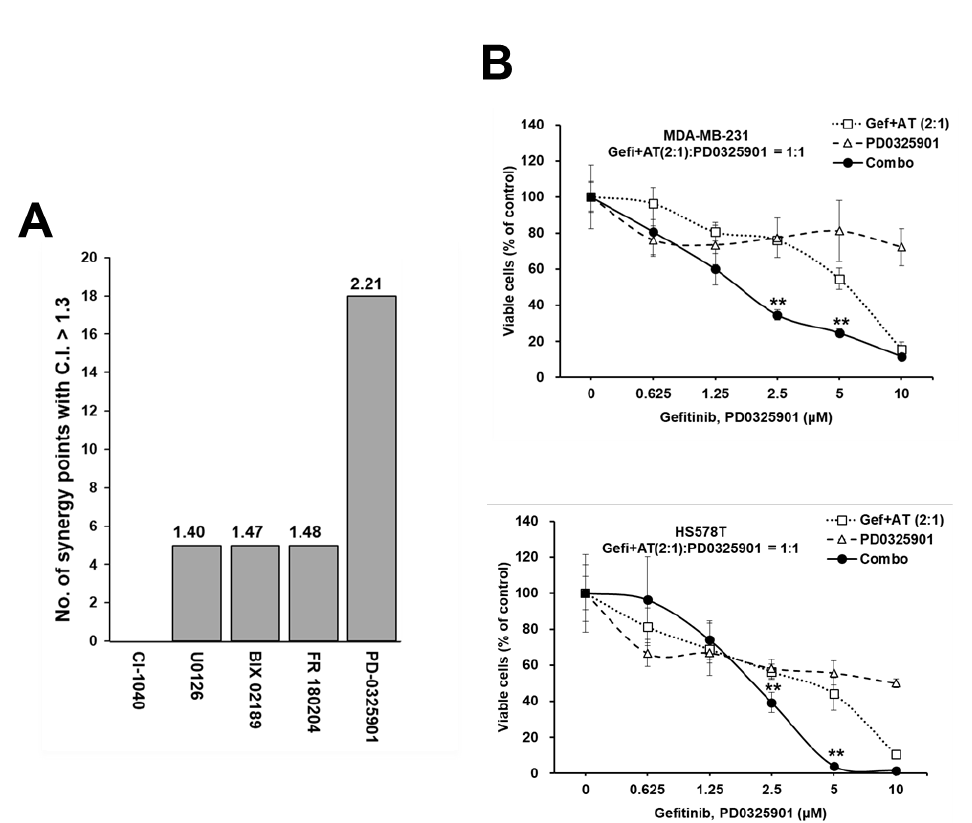
Figure 6. Synergistic anti-proliferative effect in TNBC cells via additional inhibition of the MEK/ERK pathway in the presence of Gefi+A7867. ( A ) Results of the MEK/ERK inhibitor screening with Gefi+AT7867 in MDA-MB-231 cells. The numbers of combination points with a CI > 1.3 are depicted, and the numbers on the top of each bar are the mean CI values of the indicated drugs. ( B ) The combination effects of PD-0325901 in the presence of Gefi+AT7867 in two TNBC cells. Cells were treated with serially diluted concentrations of PD-0325901 in the presence of Gefi+AT7867 for 72 h. Data represent mean ± SD from at least three independent experiments performed in triplicate. ** p < 0.01.